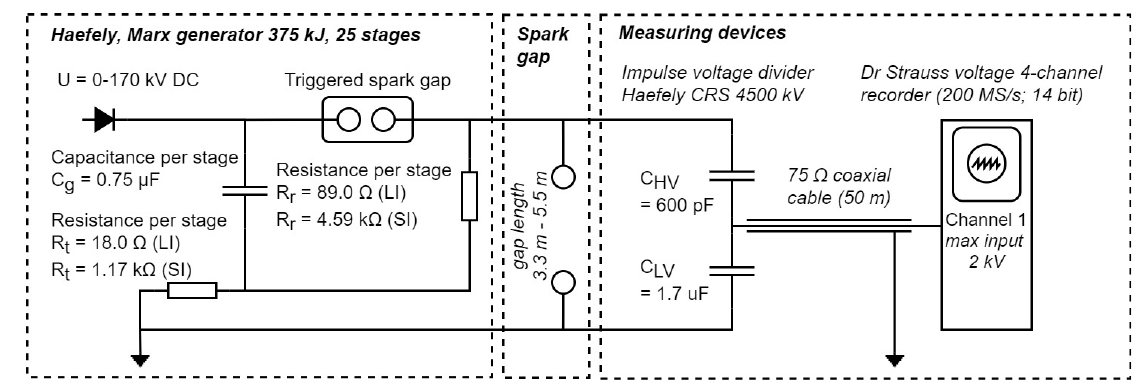
Figure 2. Measurement test set-up: 25-stage Marx impulse voltage generator (375 kJ, 25 steps), Capacitive Impulse Voltage Divider CRS (4500 kV, ratio 3150), Dr Strauss TR-AS 200-14 4-channel digital voltage recorder (2 kV, 14 bit), 200/50 MS/s samplings for lightning/switching impulse voltage respectively.